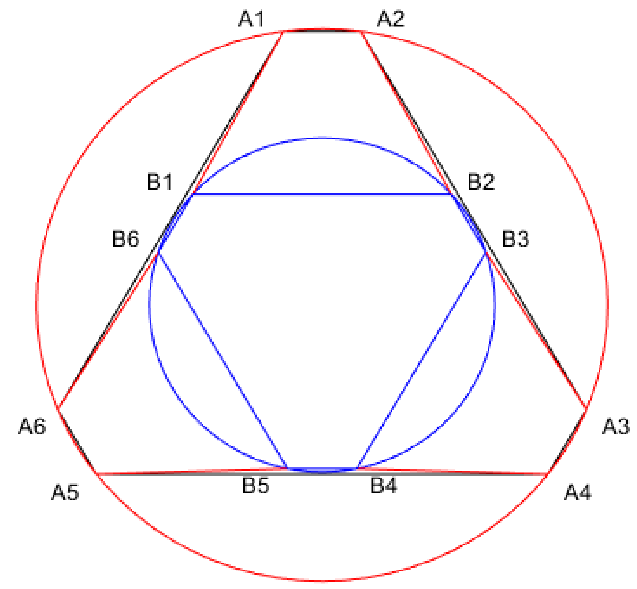
Figure 2. Top view of the parallel platform in zero state.